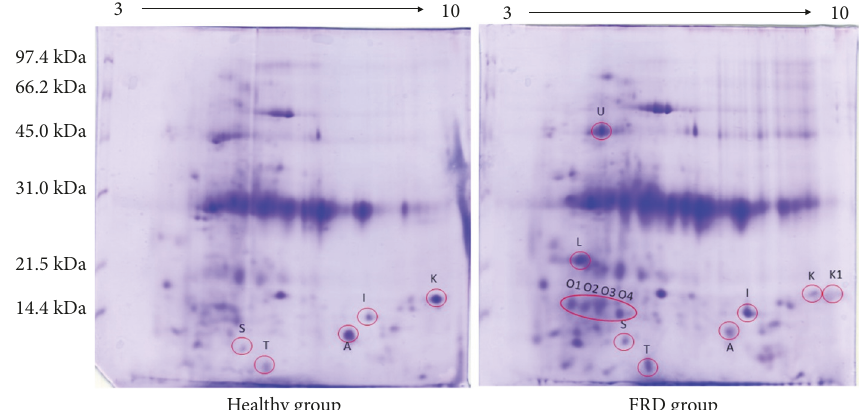
Figure 1: 2DE map of the feces proteins from healthy dog group and FRD dog group. The experiments were performed in triplicate for the two samples. Differently expressed protein spots are evidenced in red (see also Table 1 for protein identification). First dimension has been performed using an immobilized pH 3–10 linear gradient strip whereas the second dimension was a 13% SDS-PAGE. The standards were Bio-Rad low molecular weight (phosphorylase b, 97.4 kDa; bovine serum albumin, 66.2 kDa; ovalbumin 45.0 kDa; carbonic anhydrase, 31.0 kDa; soybean trypsin inhibitor, 21.5 kDa; lysozyme, 14.4 kDa).